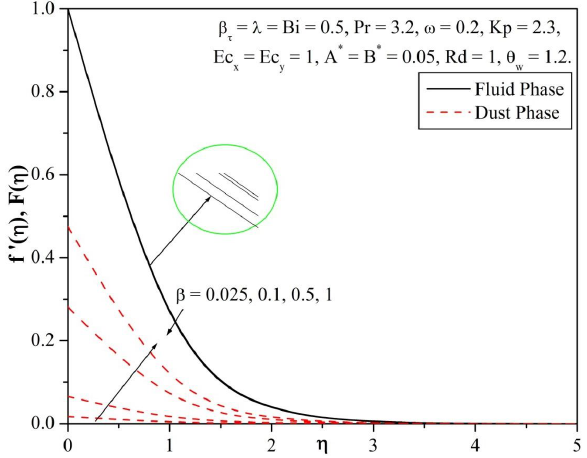
Fig. 10: Dimensionless temperature profiles for different values of A * .